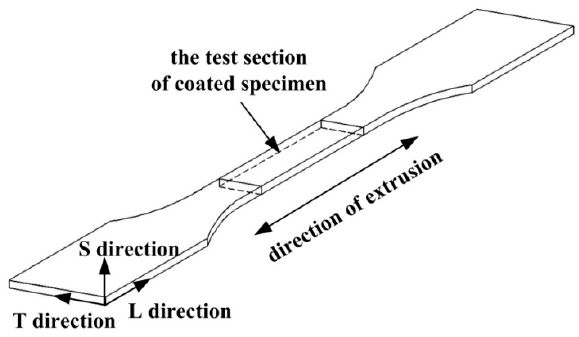
Figure 1. Schematic drawing of the specimen’s test section.